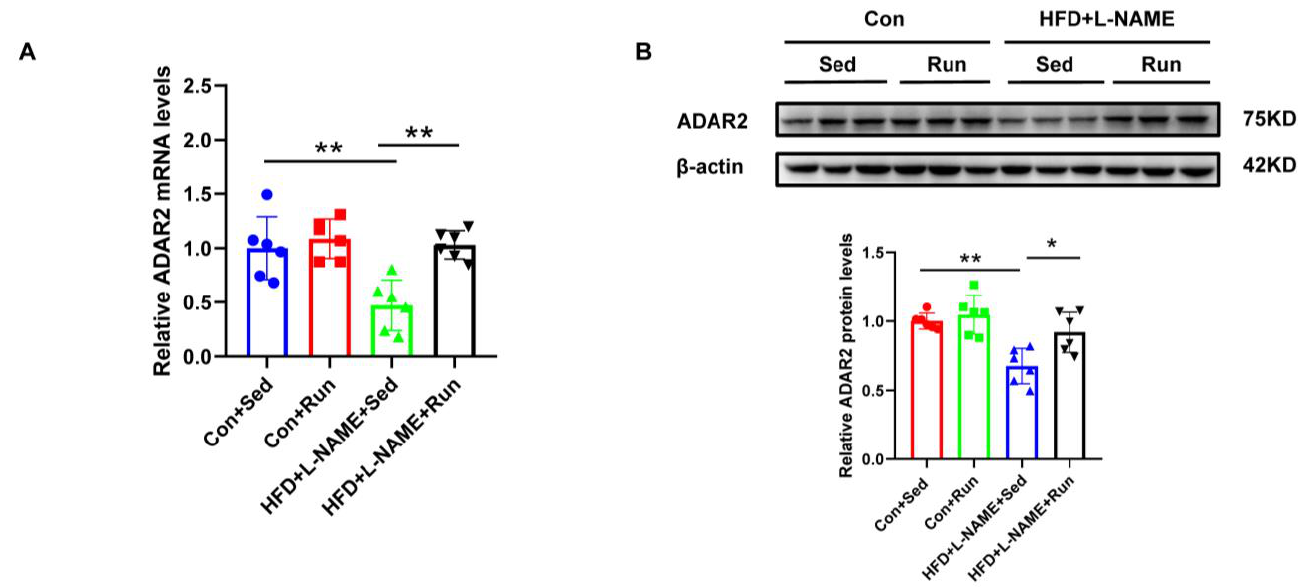
Figure 2. Hepatic ADAR2 is ameliorated by exercise in the group with diet-induced NAFLD mice. ( A ) The mRNA levels of ADAR2 relative to GAPDH in the mouse livers were analyzed by qRT- PCR. ( B ) The protein levels of ADAR2 in the mouse livers were detected using Western blotting. * p < 0.05, ** p < 0.01; n = 6. Sed, sedentary; HFD, high-fat diet; L-NAME, N ω -nitro-L-arginine methyl ester, hydrochloride; ADAR2, adenosine deaminases acting on RNA 2. ● Con+Sed; ■ Con+Run; ▲ HFD+L-NAME+Sed; ▼ HFD+L-NAME+Run.